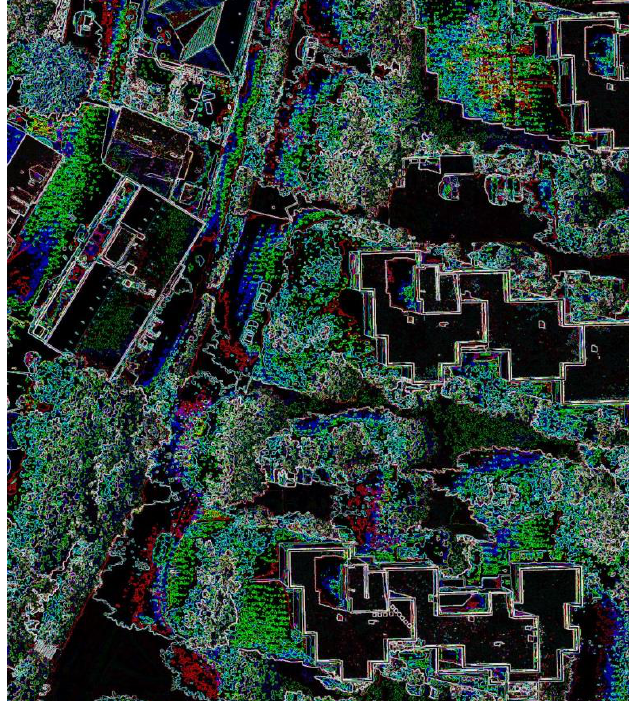
Figure 4. This figure depicts the output of colour image segmentation. The output is much better, but still some vehicles in shadow are not properly recognisable.